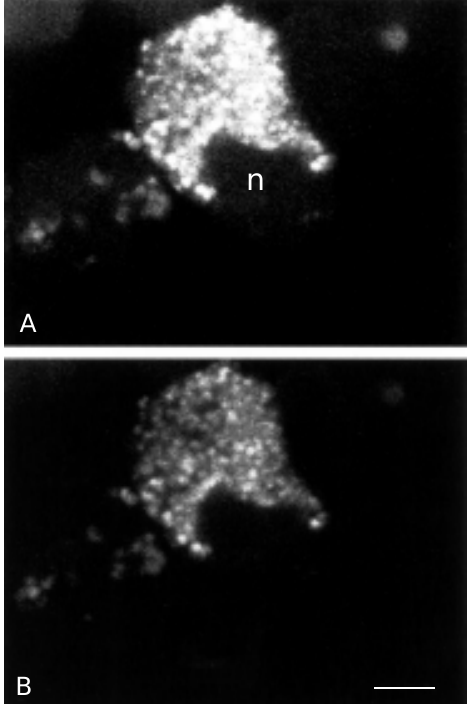
Figure 8 - Double staining of COS-7 cells transfected